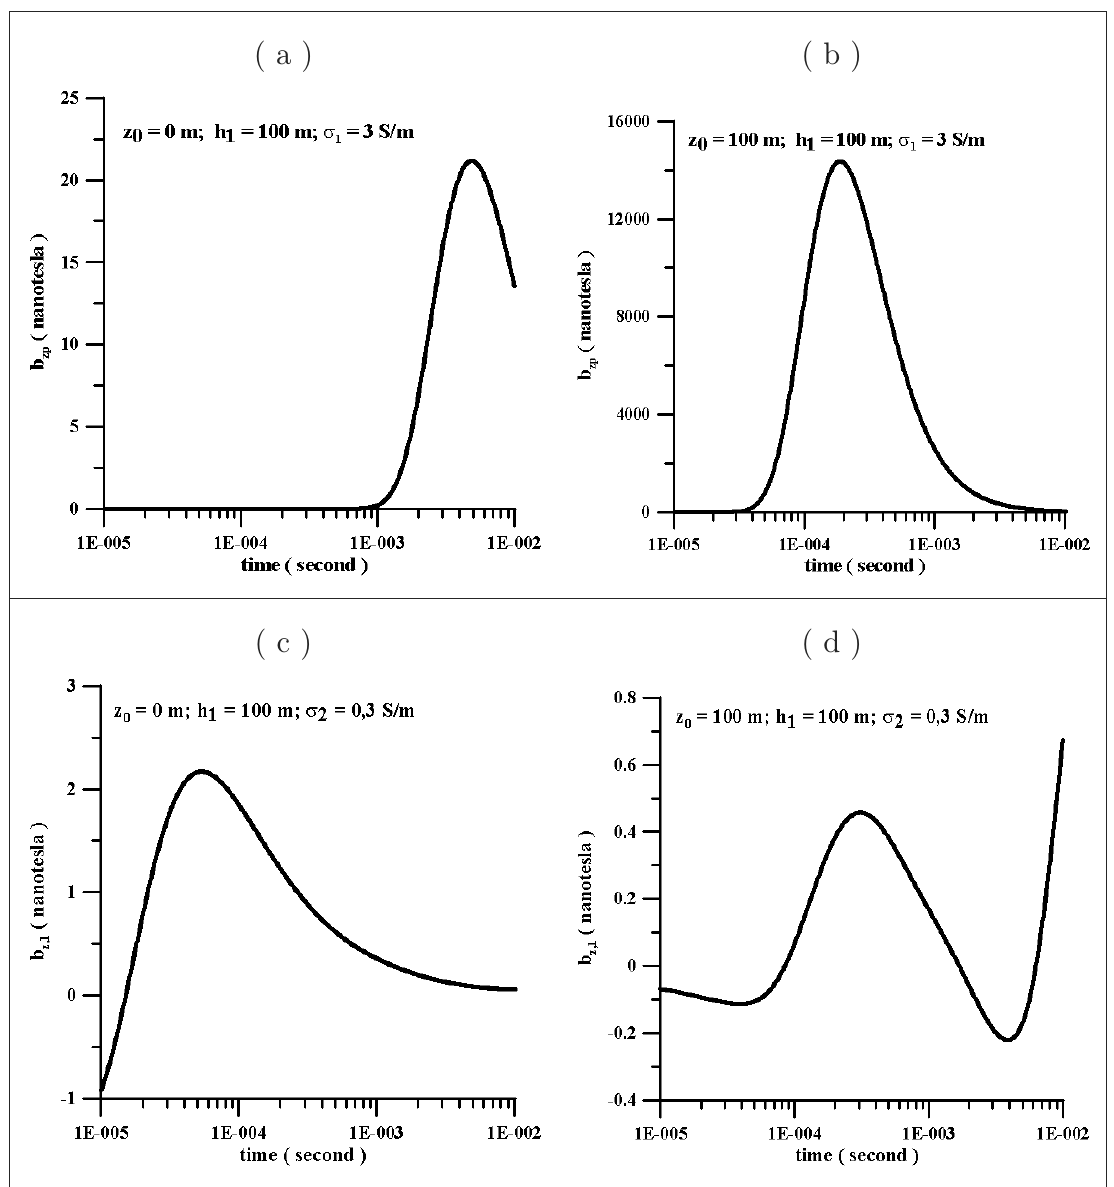
Fig. 4 – Graphs of the time variation of the vertical component of the magnetic field for the case of a water layer with h 1 = 100m and σ 1 = 3S/m, overlying a basement with σ 2 = 0 . 3S/m. Primary: b zp . Total: b z , 1